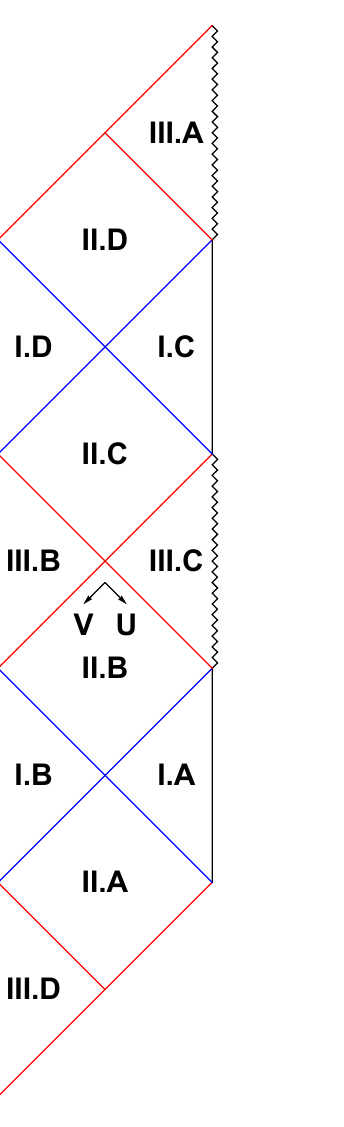
Figure 6 . Left: a Penrose diagram. If the top and bottom of the diagram are identi(cid:12)ed, it represents the hyperboloid after excising the region (cid:24) 2 < 0 and compactifying the angle (cid:30) . If instead the diagram is repeated in(cid:12)nitely in either direction, it represents the rotating BTZ black hole spacetime, the universal cover of the excised and compacti(cid:12)ed hyperboloid. Blue edges are outer horizons and red edges are inner horizons. Right: the signs of the lightcone coordinates in each patch. An embedding coordinate map for any region can be constructed by putting appropriate signs on and swapping hyperbolic functions in the maps for regions I.A, II.A, or III.A which are given in